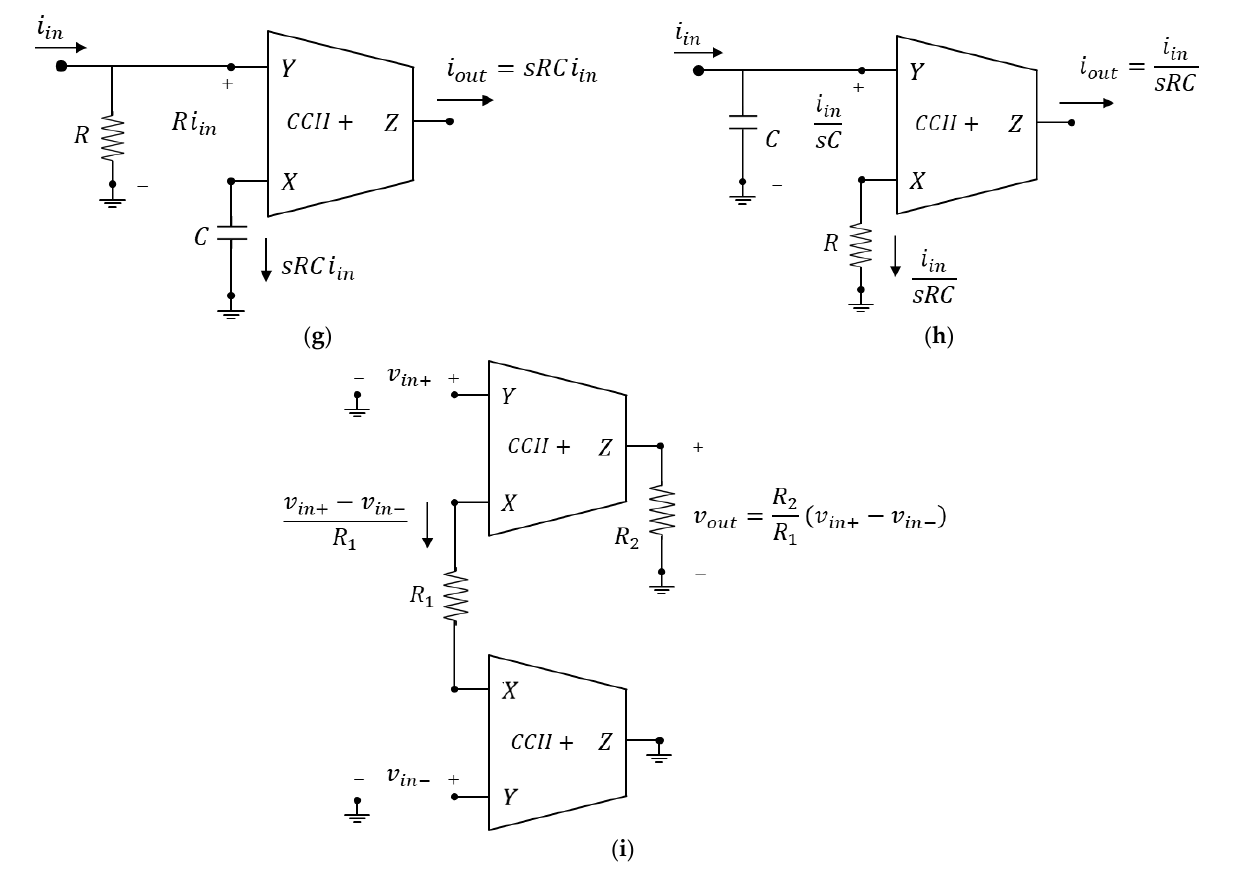
Figure 5. Basic CCII applications: ( a ) voltage amplifier; ( b ) current amplifier; ( c ) V-I converter; ( d ) I-V converter; ( e ) voltage differentiator; ( f ) voltage integrator; ( g ) current differentiator; ( h ) current integrator; ( i ) differential voltage amplifier.